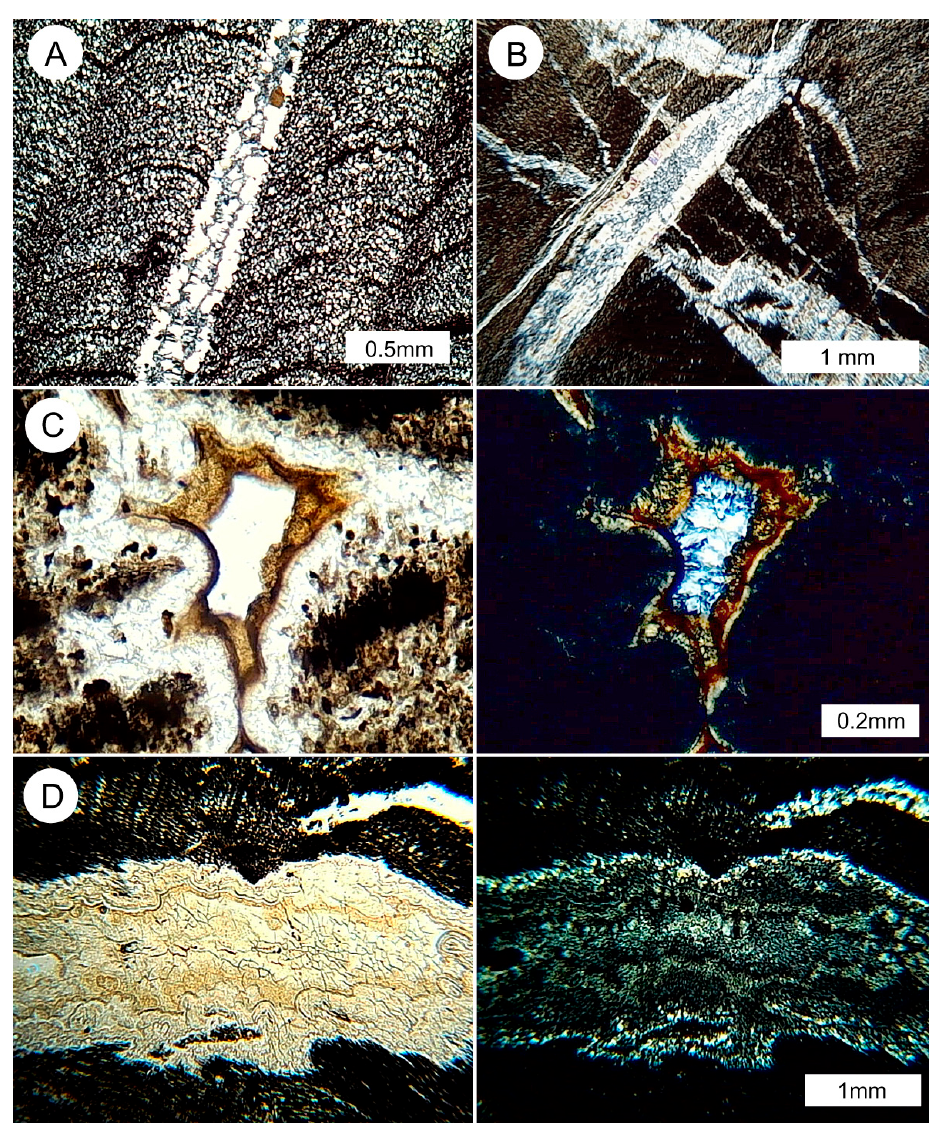
Figure 13. Evidence for multiple phases of mineralization. ( A ) Polarized light view of specimen T-10 (trunk 6), showing quartz-filled fracture in quartz-mineralized wood. ( B ) Specimen T-7 (trunk 4) contains quartz-filled fractures in quartz-mineralized wood. The cross-cutting relationships among the quartz veins are evidence that fracturing and fracture filling occurred as several episodes. ( C ) Specimen T-2 (trunk 2) is opalized wood (density 2.03 g / cm 3 ) that contains a void space having a peripheral layer of botryoidal opal-CT with quartz crystals filling the interior zone. ( D ) Specimen T-9 (log 5) has intermediate opal/quartz density of 2.30 g/cm 3 , consistent with optical photomicrographs that show isotropic opalized wood containing a zone filled with layers of opal-CT and microcrystalline quartz. For photo pairs C and D , the image on the left is ordinary transmitted light; the right image is polarized light.